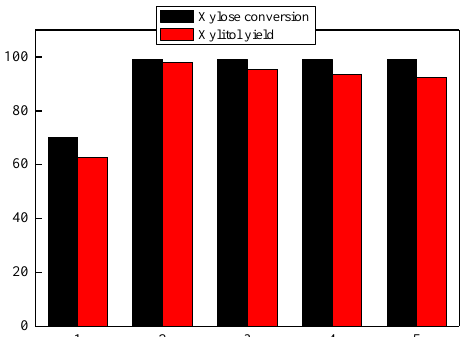
Figure 6. Effect of the Ni/Re ratio on the conversion of xylose and the yield of xylitol over various catalysts: (1) Ni / AC; (2) Ni-Re / AC (n Ni :n Re = 1:1); (3) Ni-Re / AC (n Ni :n Re = 2:1); (4) Ni-Re / AC catalysts: (1) Ni/AC; (2) Ni-Re/AC ( n :n = 1:1); (3) Ni-Re/AC ( n :n = 2:1); (4) Ni-Re/AC ( n :n = Ni Re Ni Re Ni Re (n Ni :n Re = 4:1); (5) Ni-Re / AC (n Ni :n Re = 10:1). Reaction conditions: 1.0 g xylose, 20.0 mL deionized 4:1); (5) Ni-Re/AC ( n :n = 10:1) . Reaction conditions: 1.0 g xylose, 20.0 mL deionized water, 0.1 g Ni Re water, 0.1 g catalyst, 2 MPa of H 2 , and 140 ◦ C for 1 catalyst, 2 MPa of H 2 , and 140 °C for 1 h.